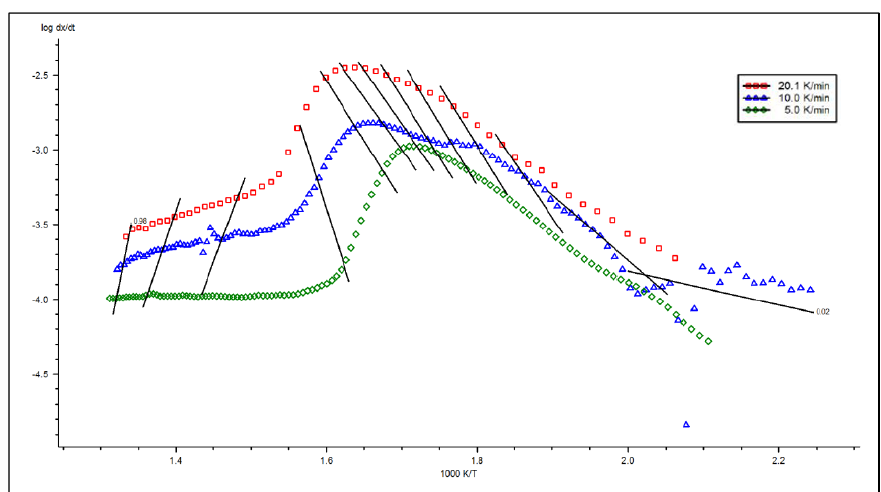
Figure A3. Log dx / dt graph as a function of temperature inverse using the Friedman method for an oat